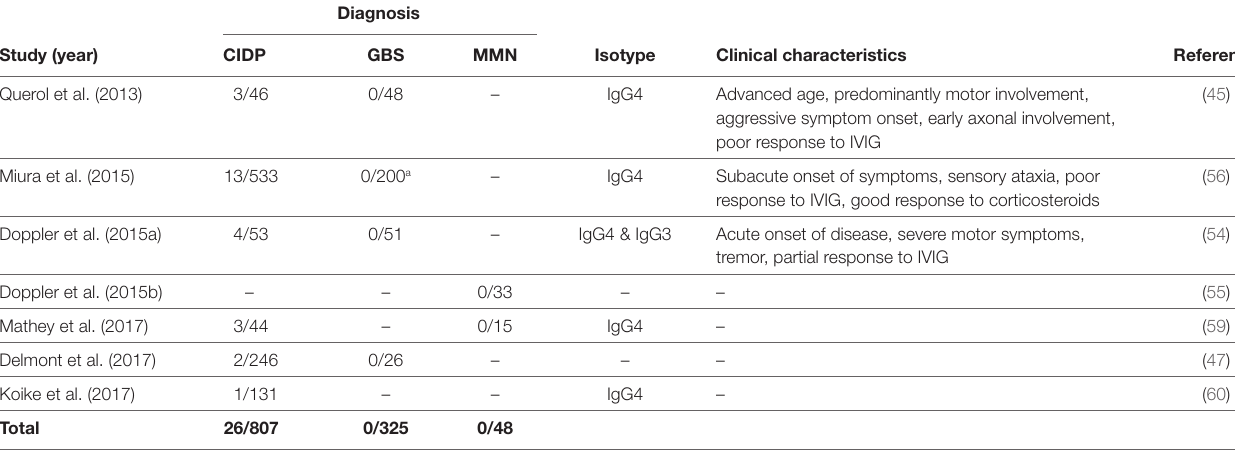
TABLe 4 | Studies that tested autoantibodies against CNTN1 by using native human